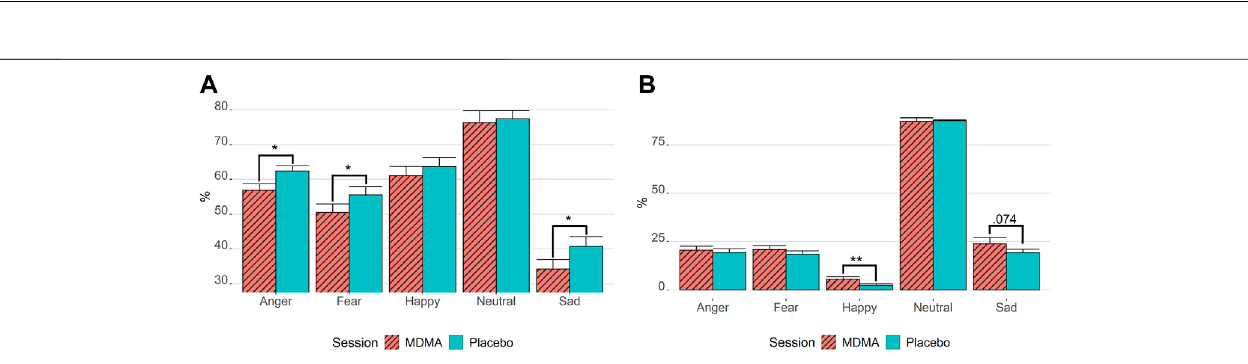
FIGURE 6 | MDMA inhibits the recognition of negative emotion and promotes misclassi fi cation as happy. Results of the facial emotion recognition task. (A) Correctly identi fi ed emotions. (B) Emotion misclassi fi cation if not correctly recognized. Stats are from paired t -tests. * p < 0.05; ** p < 0.01. Bonferroni corrected for multiple testing. MDMA, 3,4-methylenedioxymethamphetamine. Values are mean ± standard error of the mean. The task was performed 3 h after drug intake.